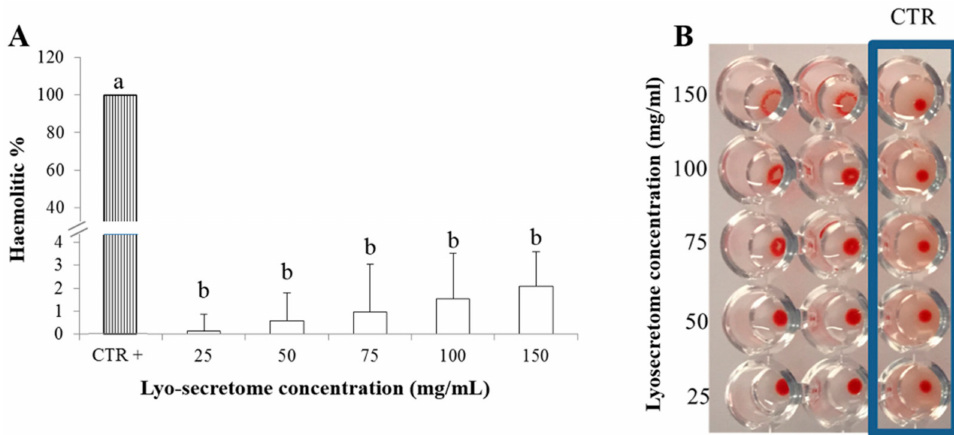
Figure 8. ( A ) In vitro lyo-secretome hemolytic test, mean values ± standard deviation ( n = 3). Different letters indicate statistical differences between the means ( p < 0.05). ( B ) In vitro hemagglutination assay.